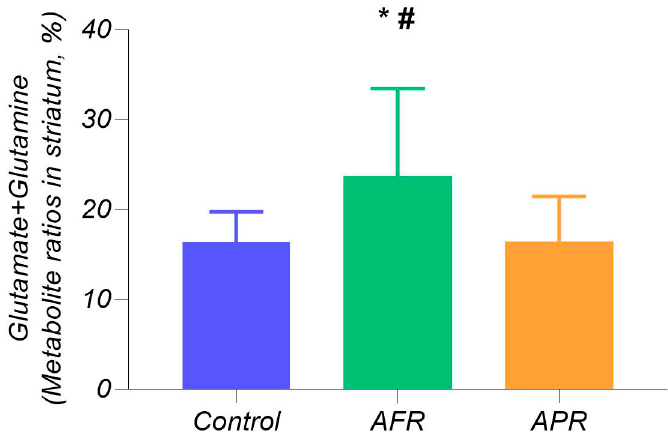
Figure 2. Long-term consequences of predator scent stress (PSS) in rat striatum. Legend: Total metabolite (%) glutamate + glutamine concentrations. * p < 0.05 in comparison with APR ( n = 12); # p < 0.05 AFR ( n = 9) in comparison with control.